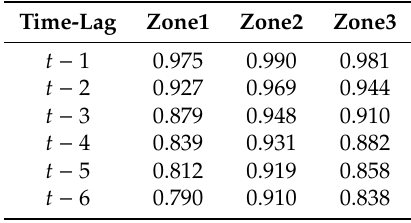
Table 1. Autocorrelation coe ffi cients of monthly average GWL in three zones. Time-Lag Zone1